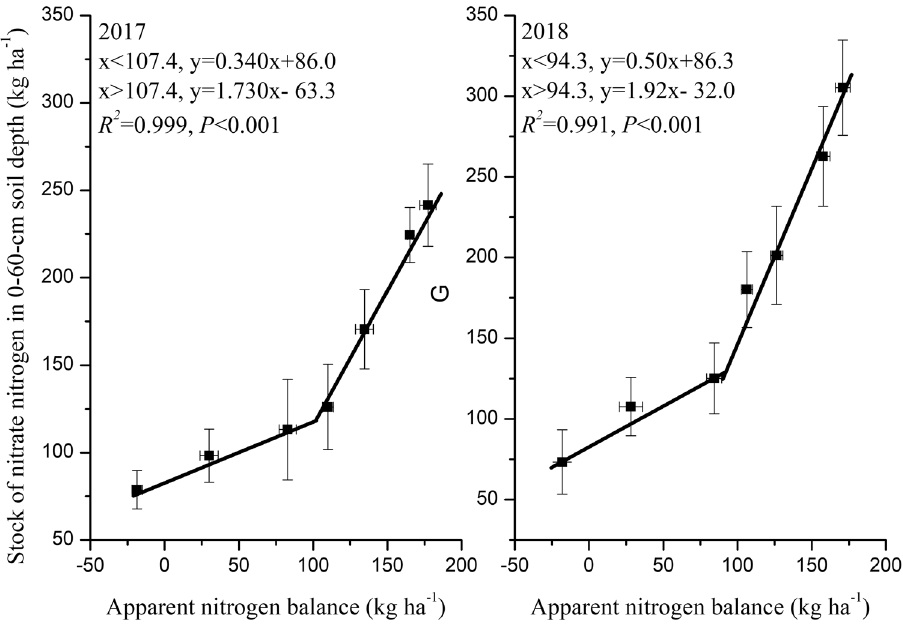
Figure 5. The relationship between the apparent nitrogen balance and nitrate nitrogen stock at the total soil depth of 0–60